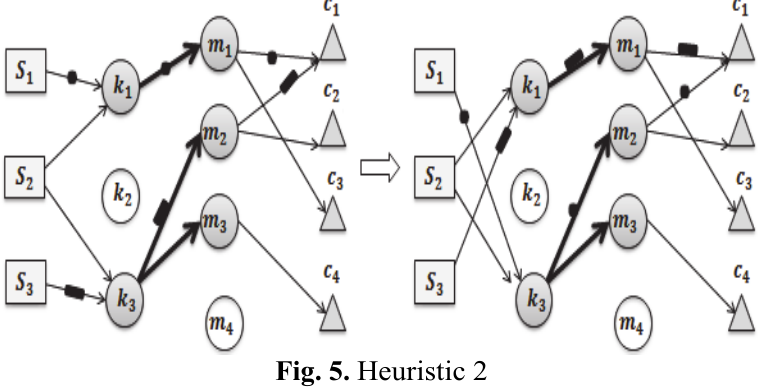
Fig. 5. Heuristic 2